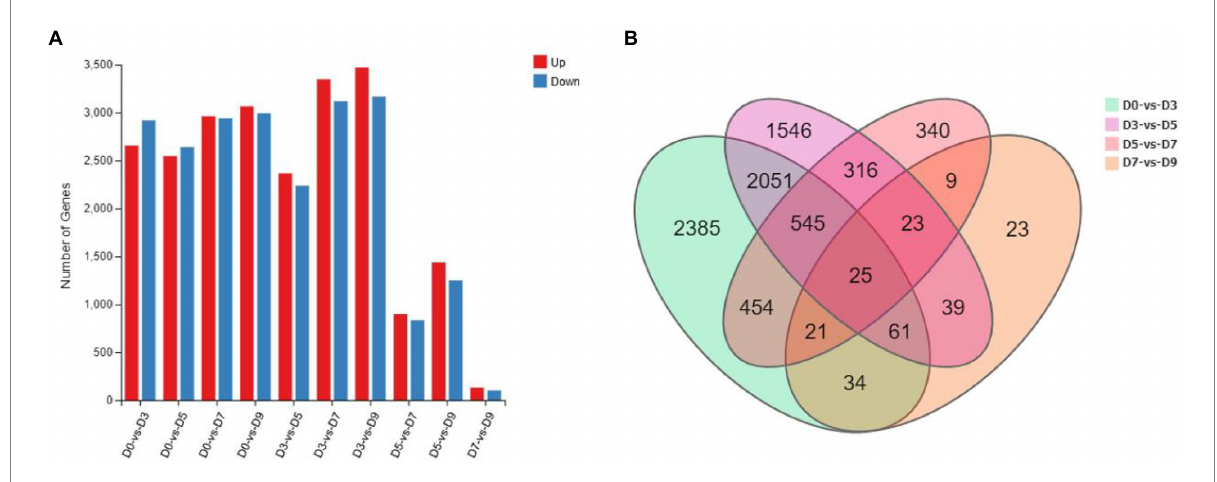
FIGURE 7 Statistics of the number of DEGs. (A) The number of up-down regulated DEGs. (B) Venn diagram of DEGs of D0- vs -D3, D3- vs -D5, D5- vs -D7, and D7- vs -D9.